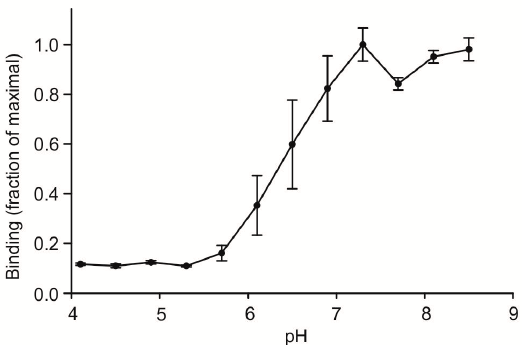
Figure 5. pH dependence of ligand binding to mouse mincle. Binding of 125 I-Man-BSA to immobilized CRD from mouse mincle was determined in a series of pH buffers formed with a mixture of 25 mM MES and 25 mM MOPS. Data are presented as mean values ± standard deviations. A midpoint of approximately pH 6.5 was obtained with two independently prepared sets of